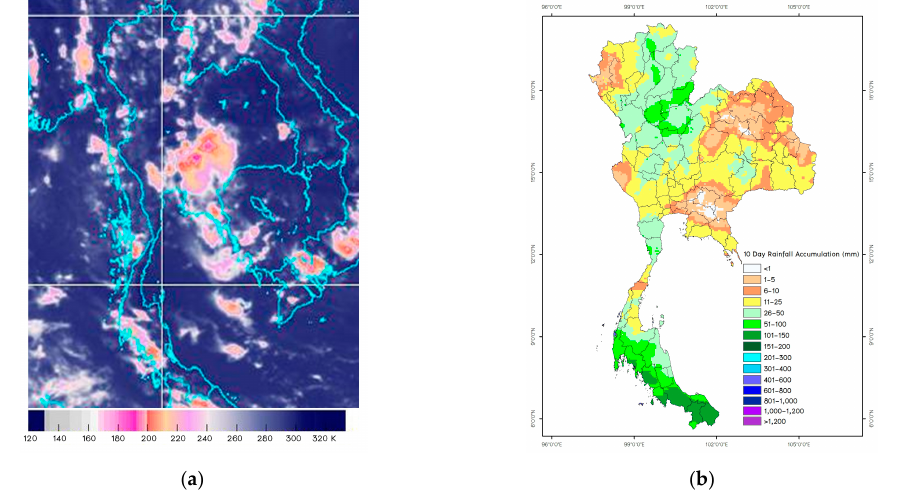
Figure 6. Examples of ( a ) IR–1 image and ( b ) dekadal (10-day) rainfall product.